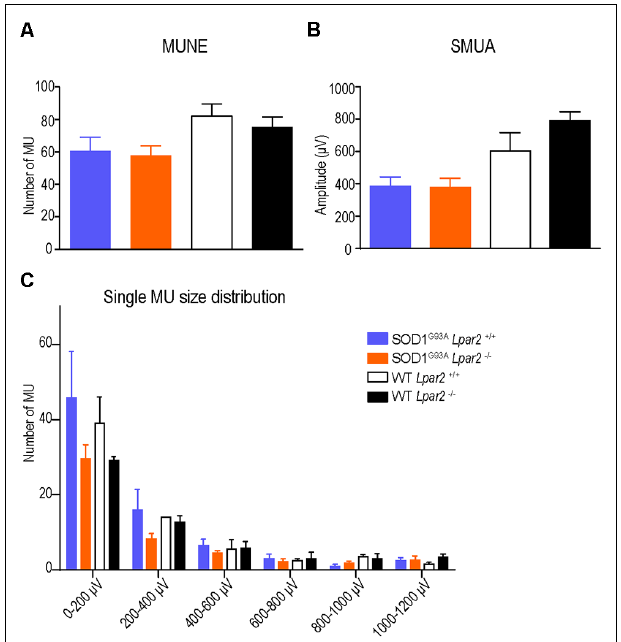
FIGURE 8 | The absence of Lpar2 does not enhance collateral sprouting. (A–C) Electrophysiological estimation of motor unit number (A) , mean amplitude of single motor unit potential (B) , and single size of motor units (C) of the gastrocnemius muscle at 16 weeks of age in male mice. Note that the absence of Lpar2 does not modify any of these parameters (males; n = 5 SOD1 G93A Lpar2 − / − , n = 8 SOD1 G93A Lpar2 +/+ , n = 5 WT Lpar2 − / − , n = 3 WT Lpar2 +/+ ). One-way ANOVA with Bonferroni’s post hoc test in (A,B) ; Two-way RM ANOVA with Bonferroni’s post hoc test in (C) . Data shown as mean ± SEM.